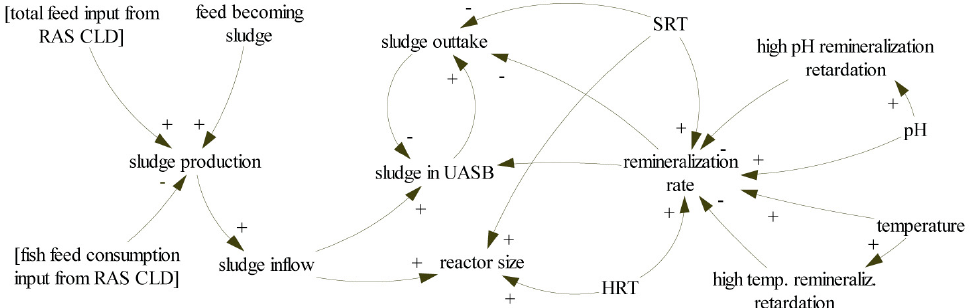
Figure B3. Causal loop diagram of the UASB. The remineralization mechanisms of the UASB show